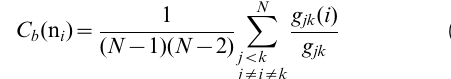
Figure S1 Equilibrium Fluctuations of the HtpG Crystal Structures. A comparative analysis of equilibrium fluctuations